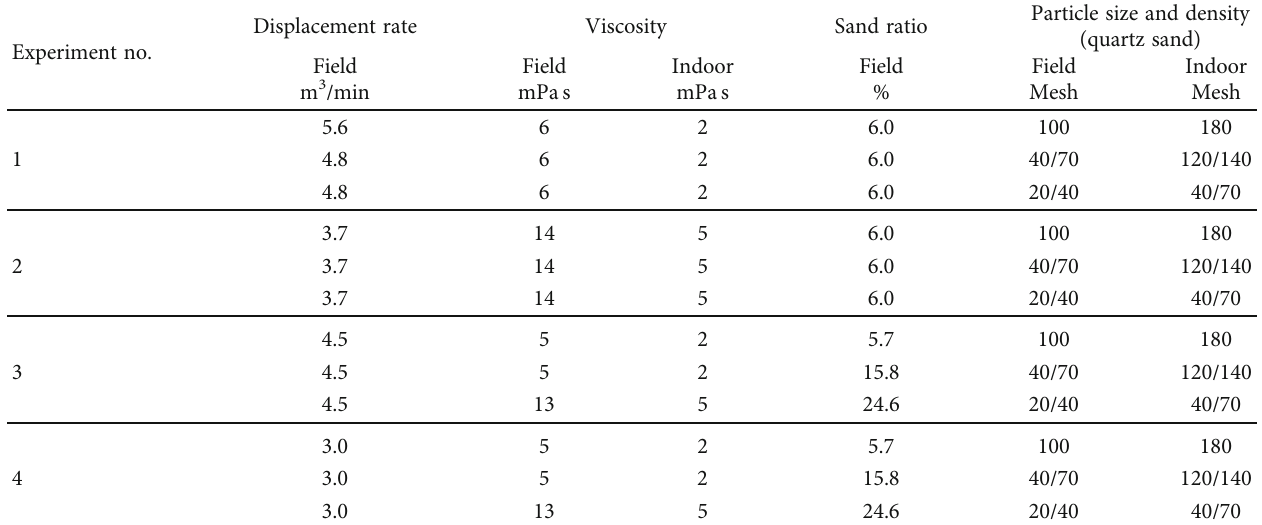
Table 2: Evaluation experiment scheme of LD C7.